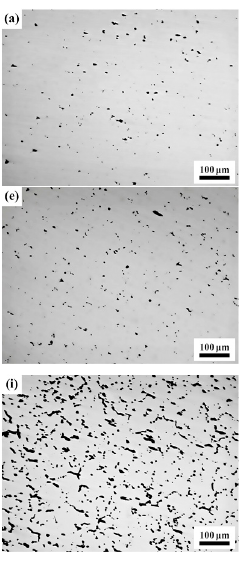
Figure 5. OM images of the Ni1# superalloy after solution heat treatment, ( a ) 1150 °C × 0.5 h, ( b ) 1150 °C × 2 h, ( c ) 1150 °C × 4 h, ( d ) 1150 °C × 8 h, ( e ) 1175 °C × 0.5 h, ( f ) 1175 °C × 2 h, ( g ) 1175 °C × 4 h, ( h ) 1175 °C × 8 h, ( i ) 1200 °C × 0.5 h, ( j ) 1200 °C × 2 h, ( k ) 1200 °C × 4 h, and ( l ) 1200 °C × 8 h.